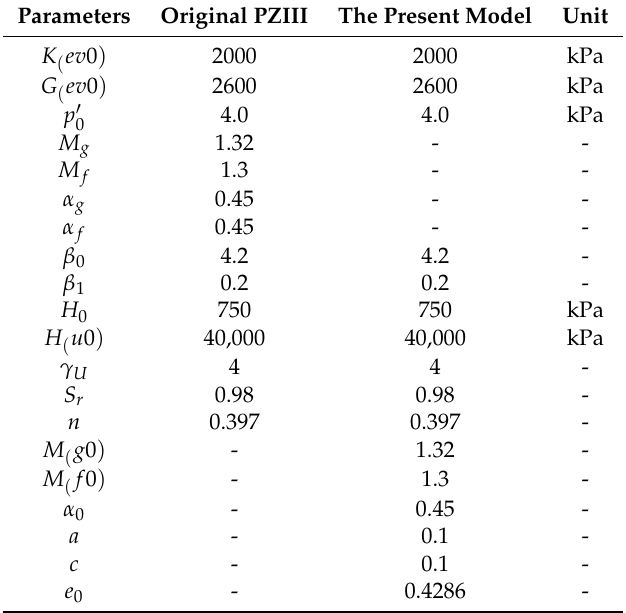
Table 3. Parameters used in dynamic constitutive model for parametric study.